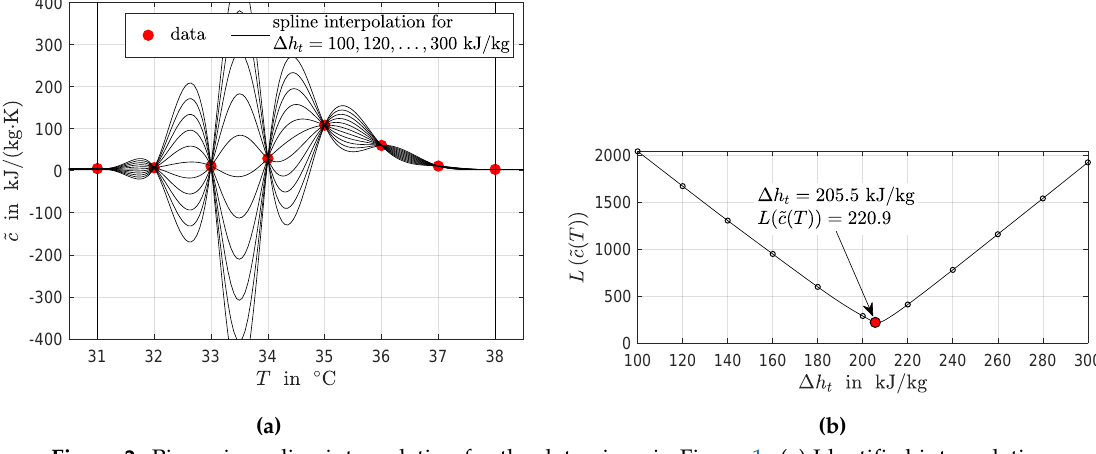
Figure 2. Piecewise spline interpolation for the data given in Figure 1. ( a ) Identified interpolating polynoms for different values of ∆ h t . ( b ) Minimization of the arc length of the interpolated apparent specific heat capacity (problem Equation (14)). Each value of ∆ h t marked by a black dot corresponds to one polynom in ( a